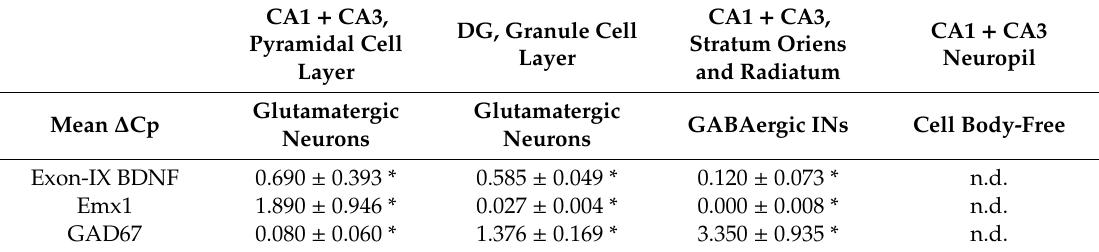
Table 3. Delta-Cp values for transcripts of BDNF and neuronal markers in LCM-captured hippocampal neurons and neuropil